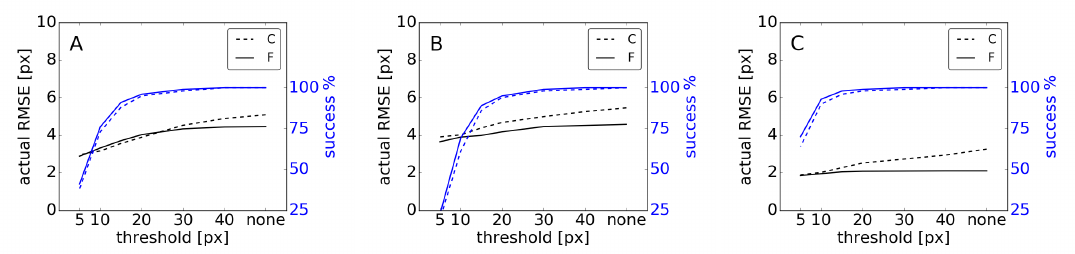
Figure 10. Actual RMSE (RMS distances in pixels between manual and automatic shorelines, in black) and success percentage (in blue) for all dates using different thresholds for the self-computed errors of beaches ( A ) CFA1, ( B ) BCN1 and ( C ) BCN3, for the combined (dashed) and the filtered (solid)